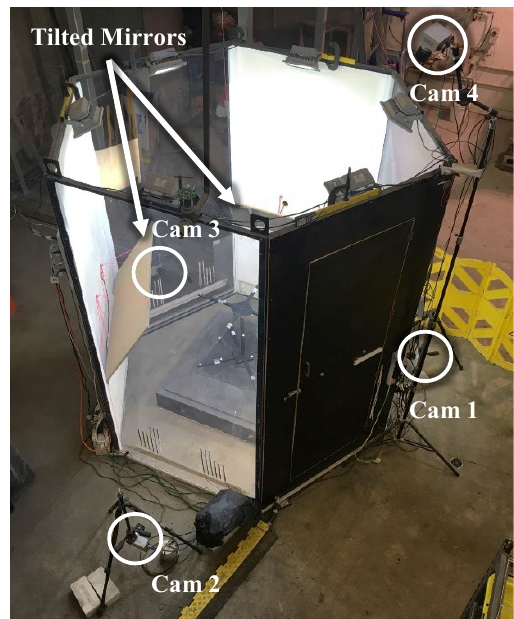
Figure 1. Experimental setup: fragmentation cell with tilted mirrors and camera positions. (a)